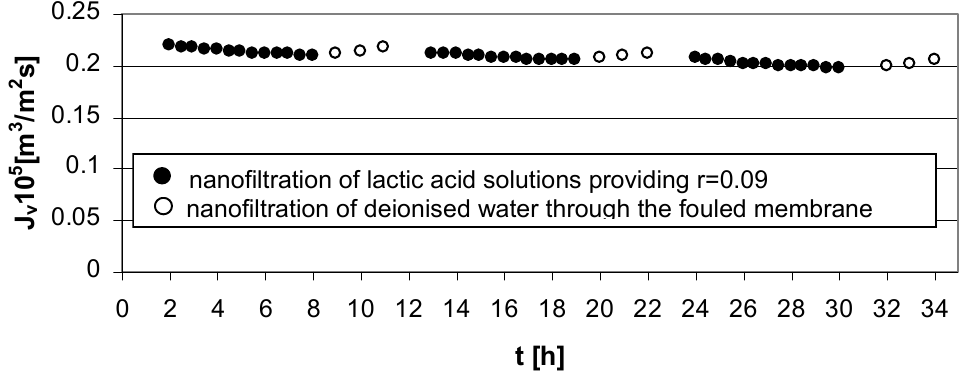
Figure 6. Permeate flux decline vs. time for operating parameters providing low lactic acid rejection, r = 0.09 (Table 1); series 1, 2, 3—nanofiltration of lactic acid solutions; series 1w, 2w, 3w—nanofiltration of deionized water; concentration of lactic acid c pH = 4.0, transmembrane pressure Δ p = 1.4 MPa, cross flow velocity u = 1.0